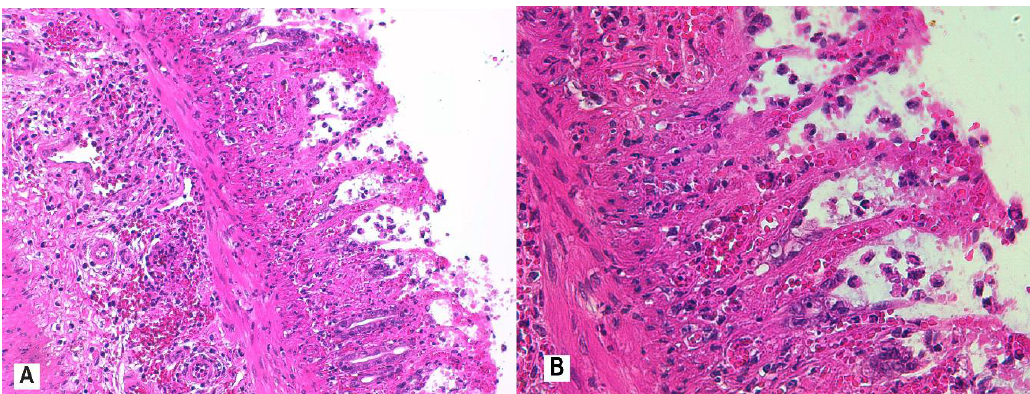
Figure 5. Colon histology of rats in the control group. Control group displayed a normal colonic mucosa, with intact and continuous surface epithelium and closely packed, thin, and long simple tubular colonic glands extending to the muscularis mucosa; small number of inflammatory cells in the mucosa and submucosa. The goblet cells are numerous in the colonic crypts. H&E stain, 20×. Abbreviations: H&E, hematoxylin and eosin.